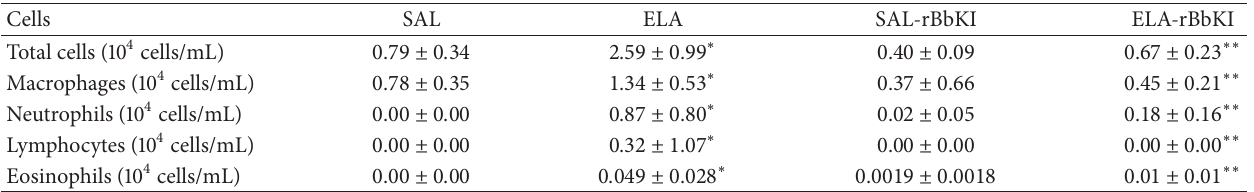
Table 1: Absolute values of amount of cells in bronchoalveolar lavage fluid (BALF). The total cells, macrophages, neutrophils, lymphocytes, and eosinophils are expressed in 10 4 cells/mL. ∗ 𝑃 < 0.05 , compared with the SAL and SAL-rBbKI groups; ∗∗ 𝑃 < 0.05 , compared with the ELA-rBbKI group.